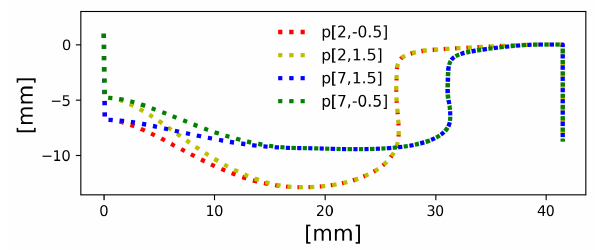
Figure 9. Boundaries of possible bowl